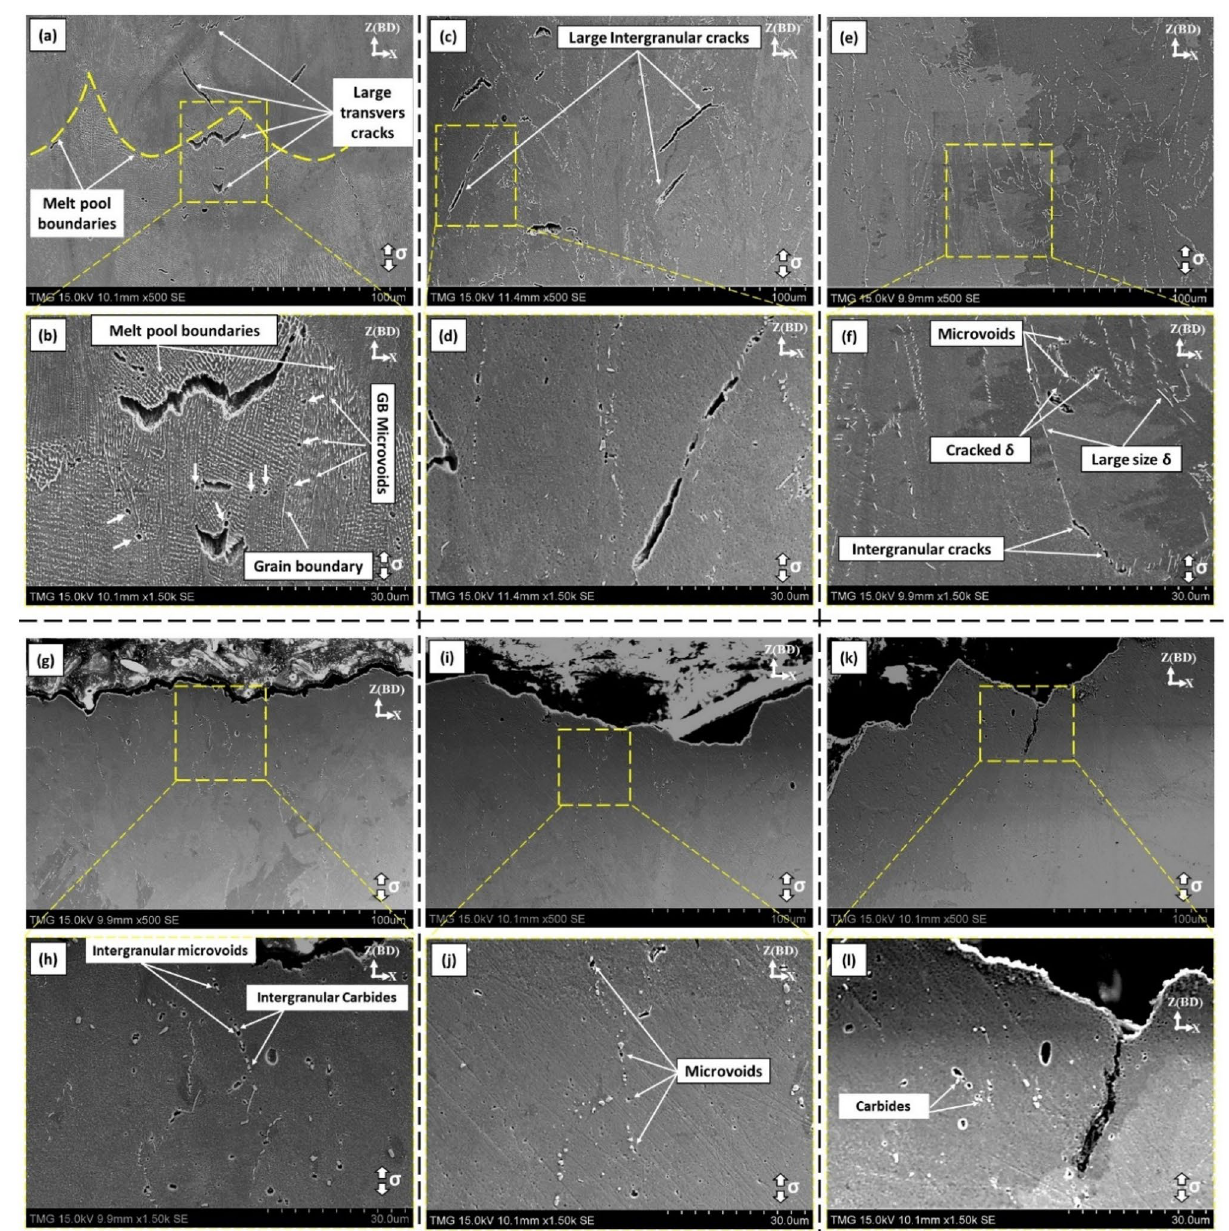
Figure 12. Fracture surface on the longitudinal plane of tensile testing of the LPBF IN718 at 650 °C: ( a , b ) as-printed; ( c , d ) HSA1; ( e , f ) HSA2; ( g , h ) HSA3; ( i , j ) HSA4; ( k , l ) HSA5. Arrows in ( b ) indicates the formation of microvoids along the grain boundaries and across the grains’